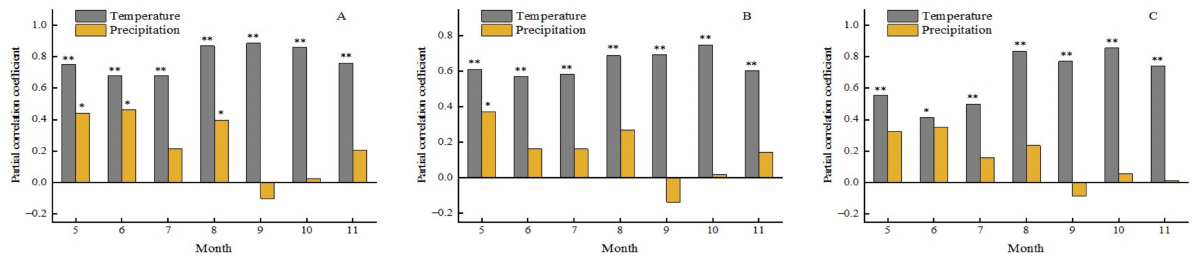
Figure 24. Partial correlation coefficient between EOS of different forest types and temperature and precipitation. ( A ) Broadleaf Forest, ( B ) Coniferous Forest, ( C ) Mixed Forest. Note: * p < 0.05, ** p <